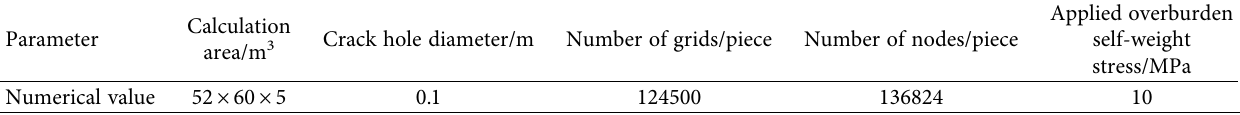
Table 1: Basic parameters of coal